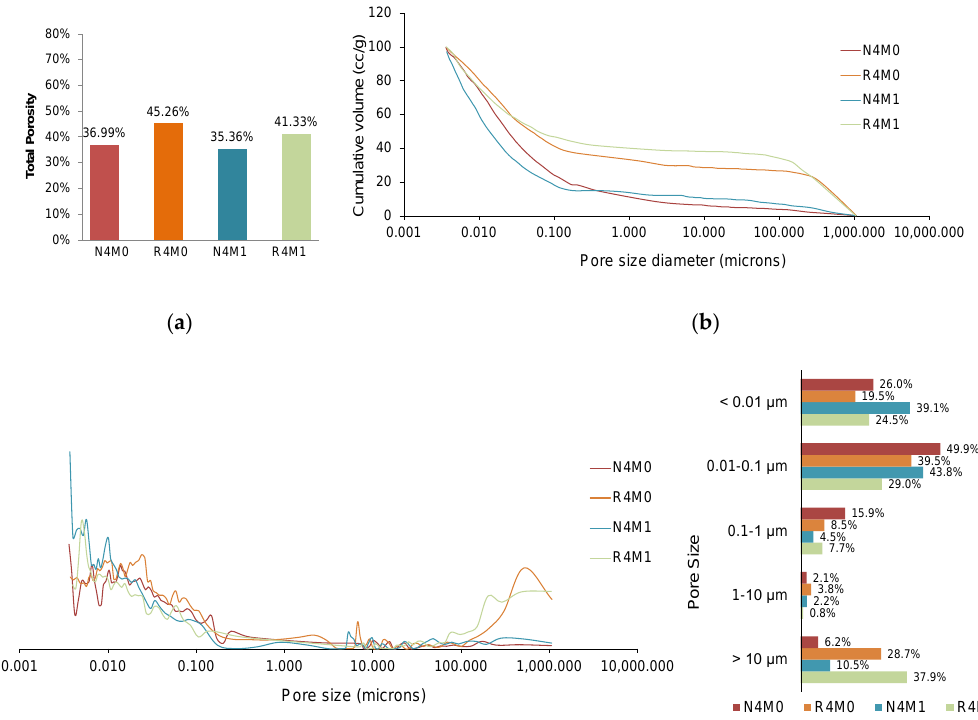
Figure 11. MIP results: ( a ) total porosity, ( b ) cumulative intrusion curve, ( c , d ) pore size distribution.